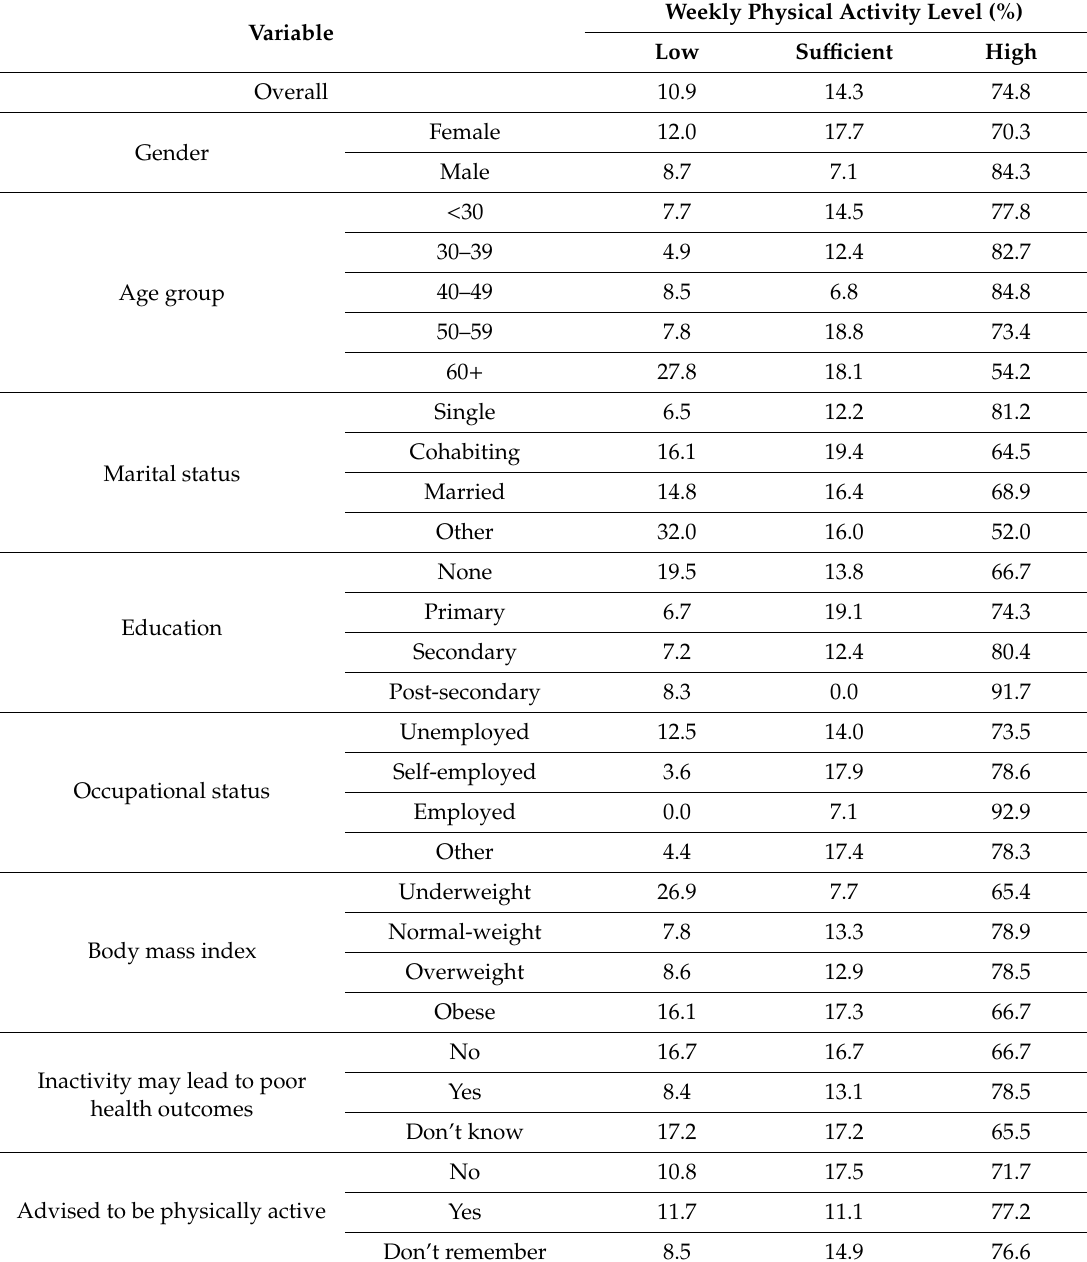
Table 2. Classification of weekly physical